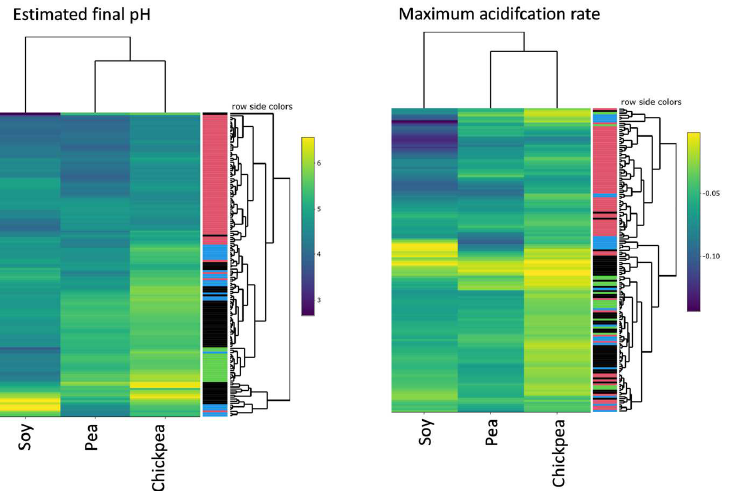
Figure 1. Estimated final pH and the maximum acidification rate determined for 148 bacterial strains (each branch on the right hand dendrogram represents one strain) when grown in soy, pea, or chickpea emulsion supplemented with 0.5% glucose. Values are the mean of four biological replicates. The colours on the right-hand side dendrogram indicate Lactococcus (red), Lactobacillus (black), Streptococcus (blue), and Leuconostoc (green). For the estimated final pH, a darker colour indicates a lower pH at the end of the fermentation. For the maximum acidification rate, a darker colour (lower value) indicates a faster acidification rate (a faster drop in pH results in a more negative acidification rate).